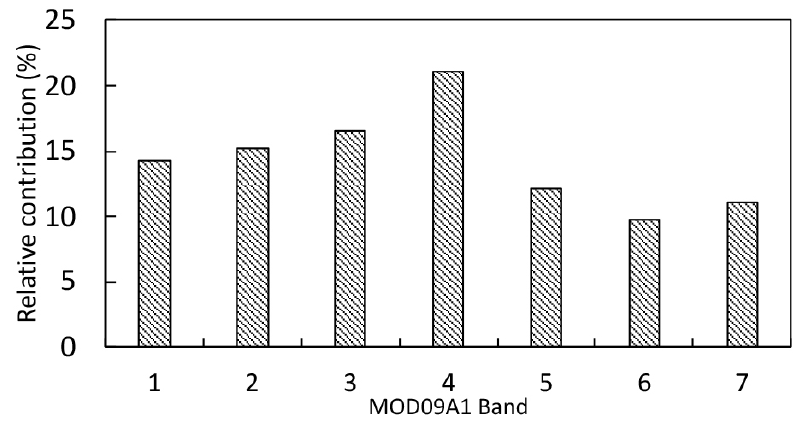
Figure 4. Relative contribution of each MOD09A1 band in MPF retrieval.